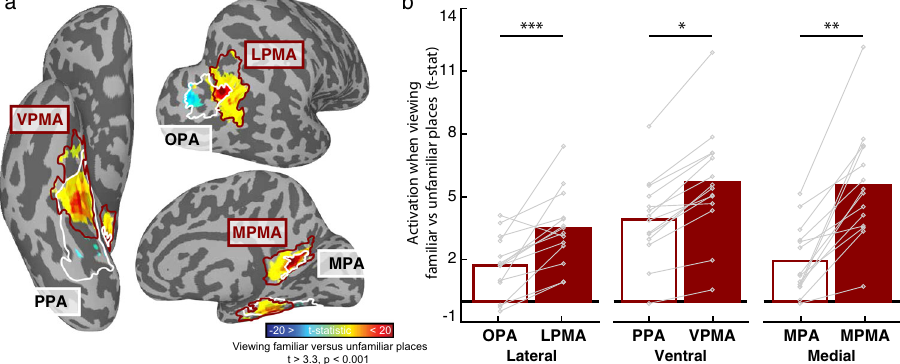
< 20-20 > Viewing familiar versus unfamiliar places t > 3.3, p < 0.001 Fig. 3 The place-memory areas respond preferentially to familiar stimuli . a , b The place-memory areas preferentially activate familiar stimuli. a. Experiment 3. Participants viewed viewing panning movies of personally familiar places versus unfamiliar places, tailored to each participant using Google StreetView (see Supplementary Videos 2 – 5). The cortical surface depicts the contrast of BOLD activity for a single participant, thresholded at vertex-wise p < 0.001. Only signi fi cant vertices within the scene perception (white) and place-memory (burgundy) areas are shown. b Average t-statistic of vertices in the scene-perception (open bars) and place-memory areas ( fi lled bars) when viewing videos of personally familiar places compared to unfamiliar places. On each cortical surface, the place-memory areas showed an enhanced response to familiar stimuli compared to the scene-perception areas (all ts > 2.6, ps < 0.01). Connected points depict individual participants. The hippocampus also showed a preferential response to familiar compared to unfamiliar place movies (Supplementary Fig. 9a). The amygdala (Supplementary Fig. 9b) and early visual cortex (Supplementary Fig. 10) did not show a preferential response to familiar place movies, arguing against a purely attentional account of this effect. OPA — occipital place area, LPMA — lateral place-memory